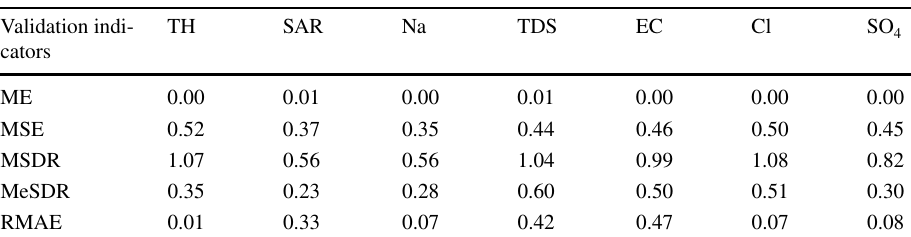
Fig. 4 Histograms of the residual analysis calculated by jackknife